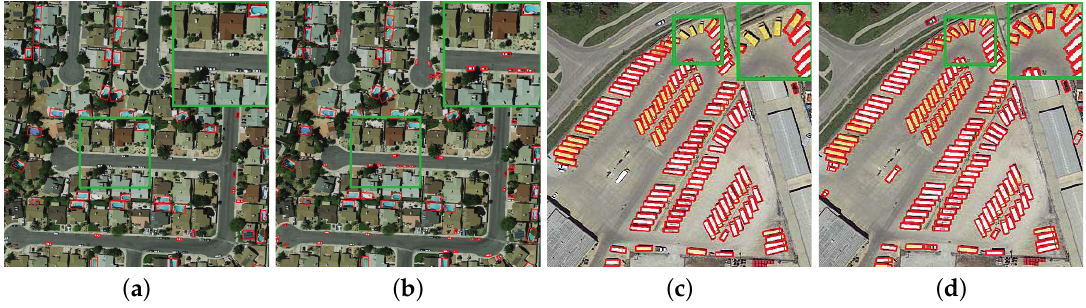
Figure 8. The effectiveness of feature fusion module. Panels ( a , c ) show the detecting results with FPN and panels ( b , d ) provide the results with feature fusion module.